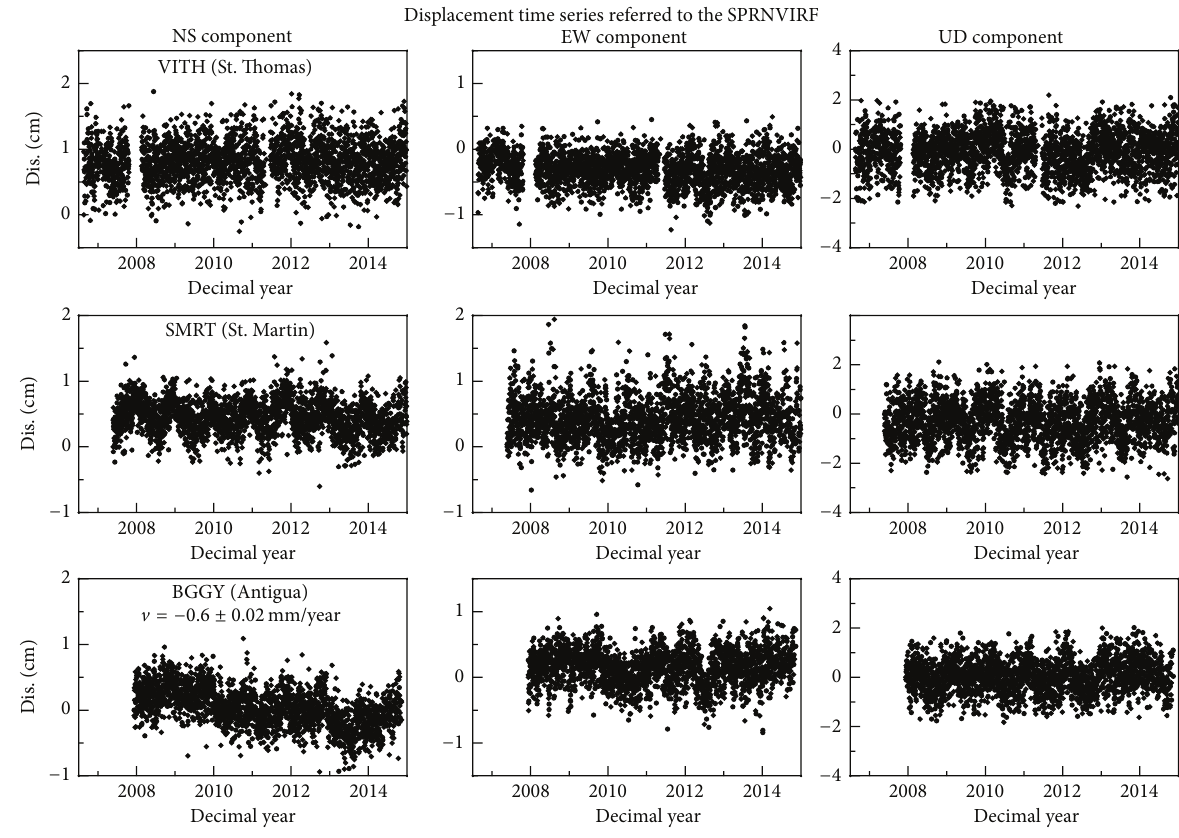
Figure 6: Daily positional time series of VITH, SMRT, and BGGY with respect to the SPRNVIRF. VITH is located on the St. Thomas island. It is one of the reference stations that were used to realize the stable local reference frame SPRNVIRF. SMRT and BGGY are two permanent stations on the Lesser Antilles outer forearc.